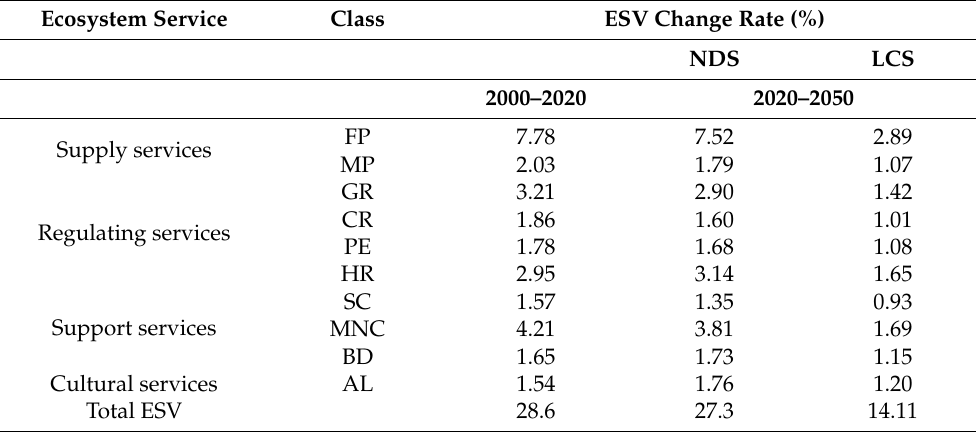
Figure 9. Changes in the individual ecosystem service value (ESV) in Fujian coastal areas from 2000 to 2050. Food production (FP), material production (MP), gas regulation (GR), climate regulation (CR), purified environment (PE), hydrological regulation (HR), soil conservation (SC), maintain nutrient cycle (MNC), biodiversity (BD), aesthetic landscape (AL), supply services (SS 1 ), regulating services (RS), support services (SS 2 ), cultural services (CS). The overall ESV decreased from 2000 to 2020, with a change rate of 28.6%. From 2020 to 2050, the overall ESV also dropped, with a change rate under NDS of 27.3%, whereas it was 14.11% under LCS. Among the individual ESV, the decline rate of food production was the largest, reaching 7.78% from 2000 to 2020, which is related to the loss of cultivated land in Fujian coastal areas. The rate of change of ESV in food production will still rank first by 2050. Under the NDS, the decline rate of food production reached 7.51%, and un- der the LCS, the decrease rate was 2.88%, indicating that LCS can reduce the serious situ- ation of farmland loss (Table 2). Table 2. Changes in ESV in the study area from 2000 to 2050 (×10 8 yuan/hm 2 ). Ecosystem Service